Question: Does the figure show an increasing or a decreasing trend?
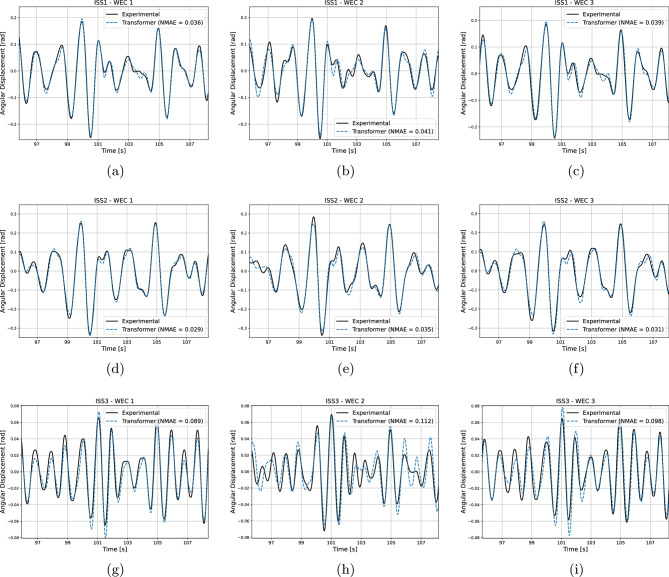
Answer: increasing